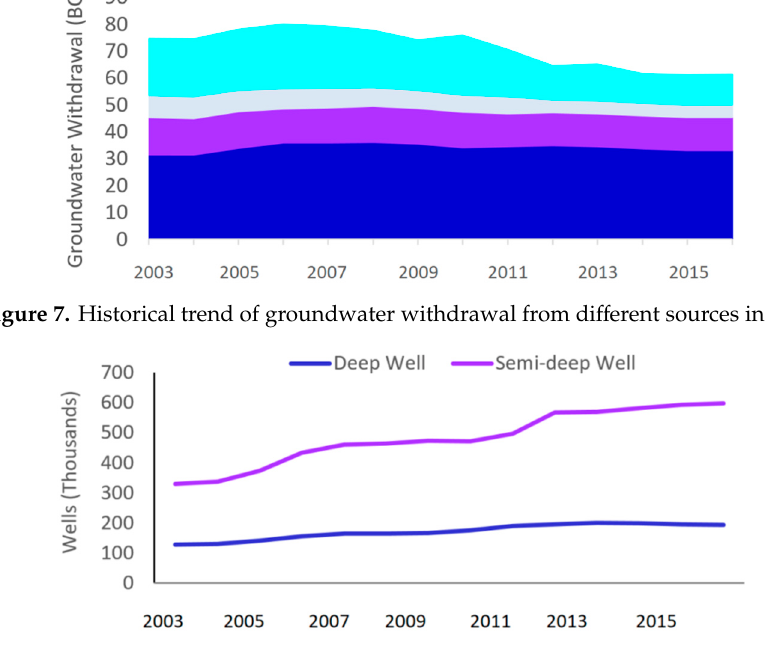
Figure 8. Number of registered deep and semi-deep water wells.